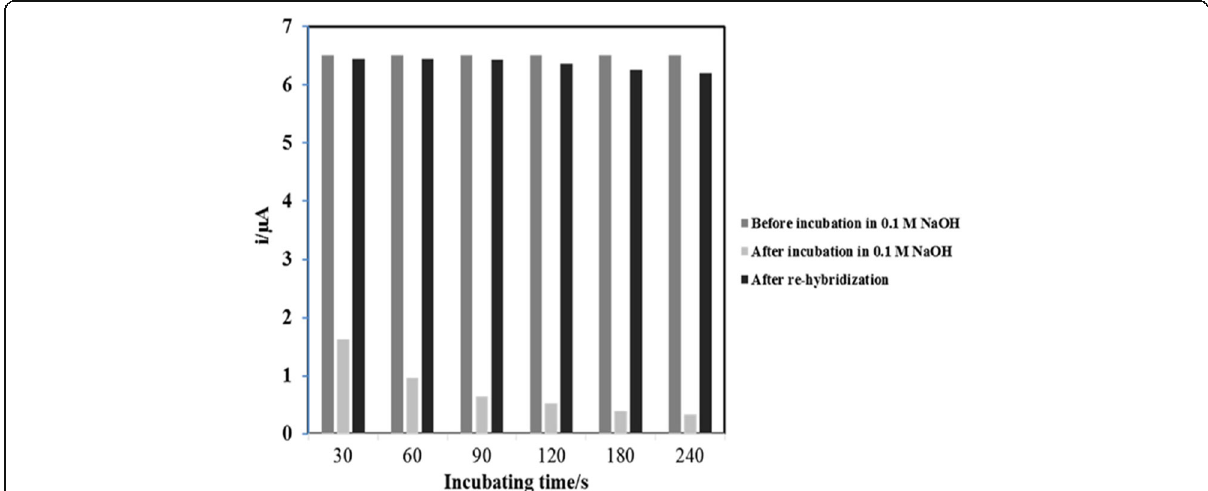
Fig. 9 Repeatability of V. cholerae DNA biosensor using 0.1 M NaOH regeneration solution and rehybridization solution containing 5 μ M cDNA